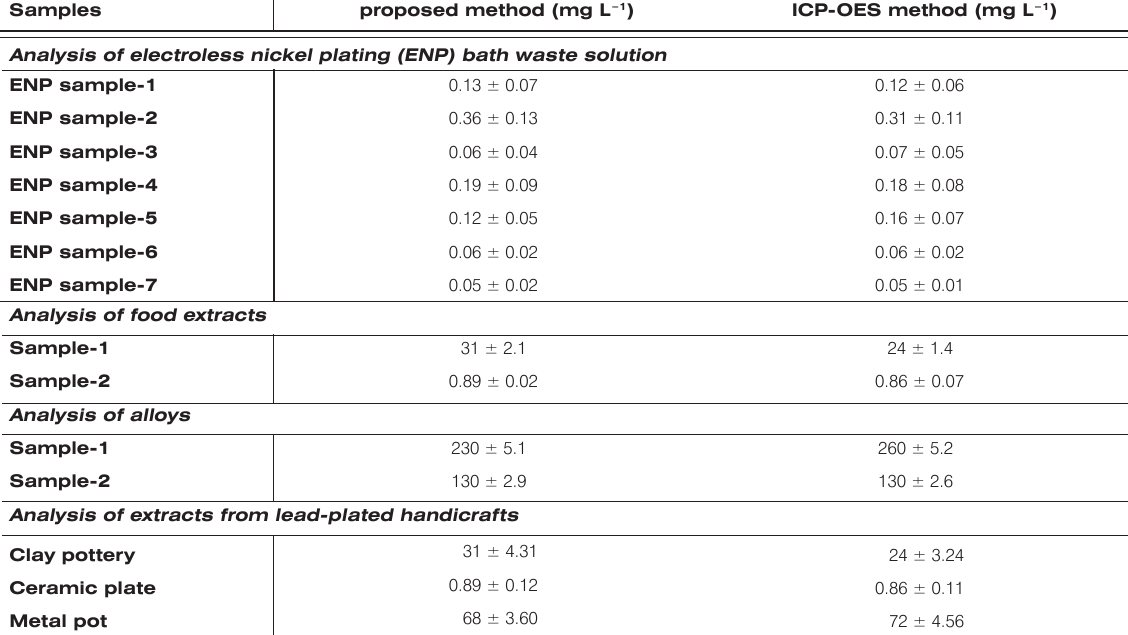
Table 2. Application to real